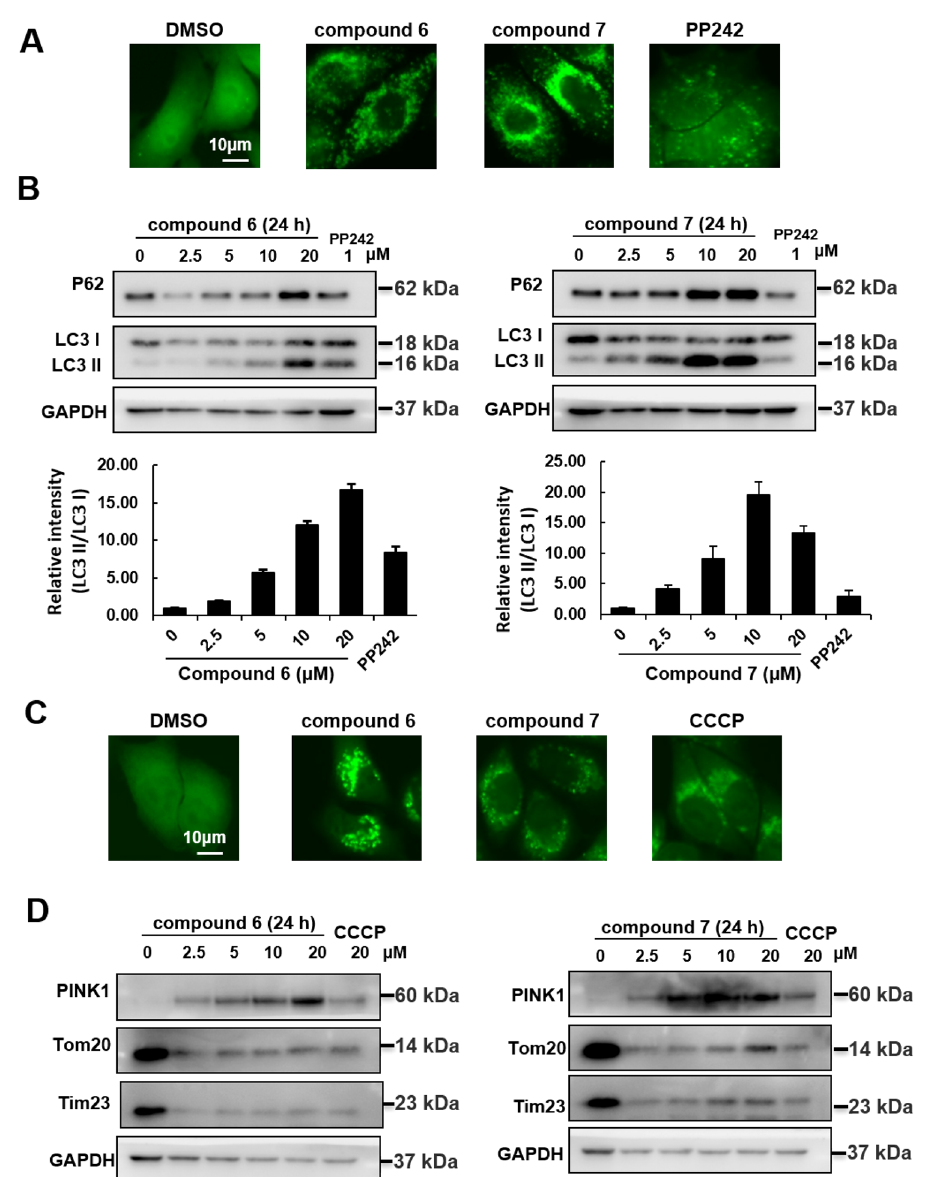
Fig. 7 Effects of compounds on autophagy/mitophagy. a Induction of autophagy in GFP-LC3 HeLa cells after 24 h and GFP-LC3 puncta were observed with a fluorescent microscope. Scale bars: 10 μ M. b Autophagy related proteins were analyzed by western blot. c Induc-